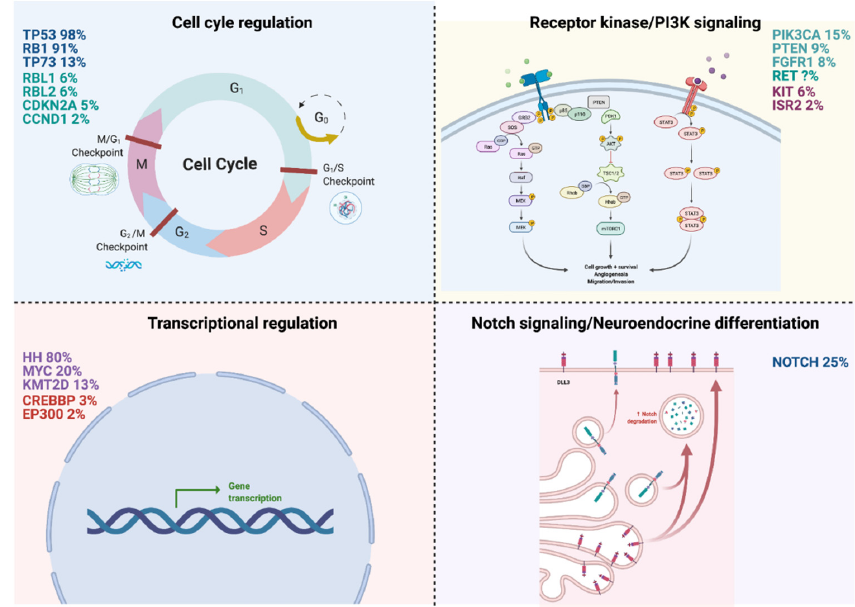
Figure 1. Signaling pathways recurrent affected in small cell lung cancer (SCLC) and frequently aberrant genes (created with BioRender.com, accessed on 28 March 2021).